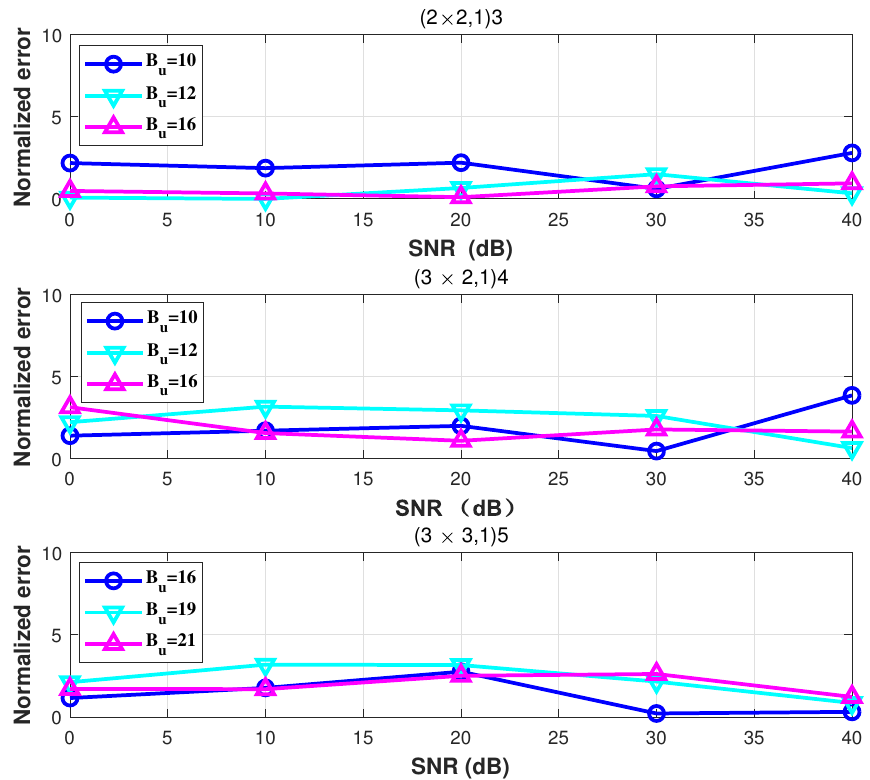
Figure 14. Normalized error of the theoretical IA sum-rate with SQ-based CSI feedback and RVQ- based DI feedback in three